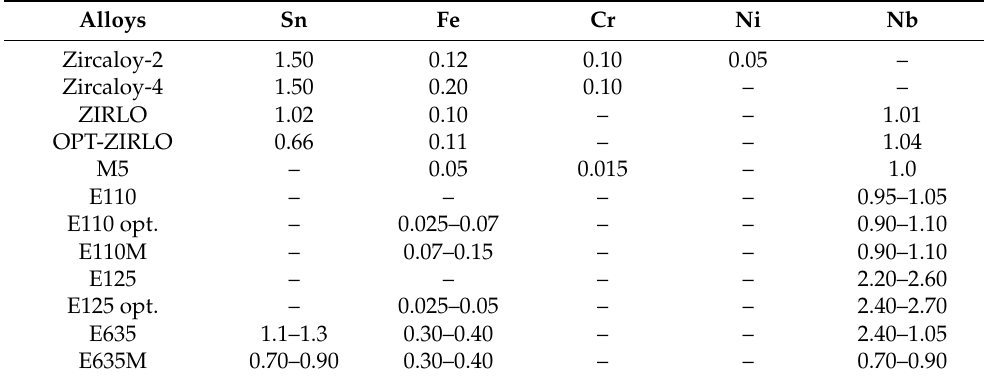
Table 1. Composition of Zirconium-alloys (wt.%)